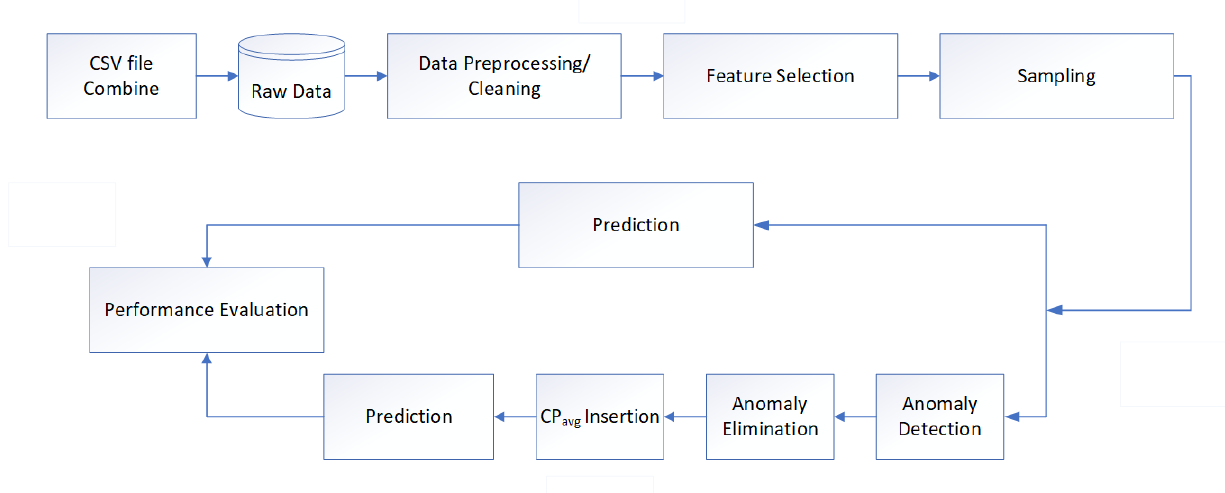
Figure 1. Framework of the load forecasting